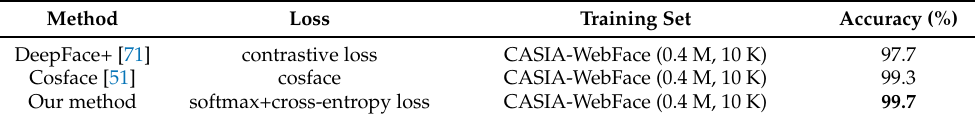
Table 14. Face recognition of different methods on the LFW dataset (using the same training dataset).